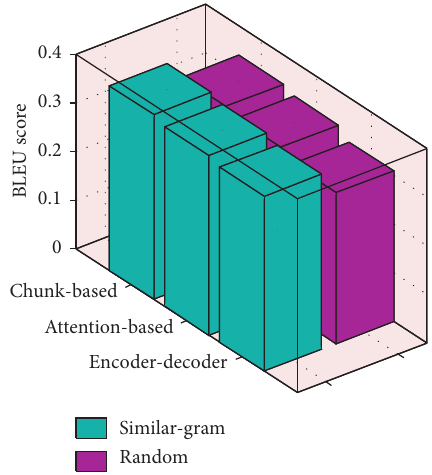
Figure 5: Comparison of experimental results of data processing